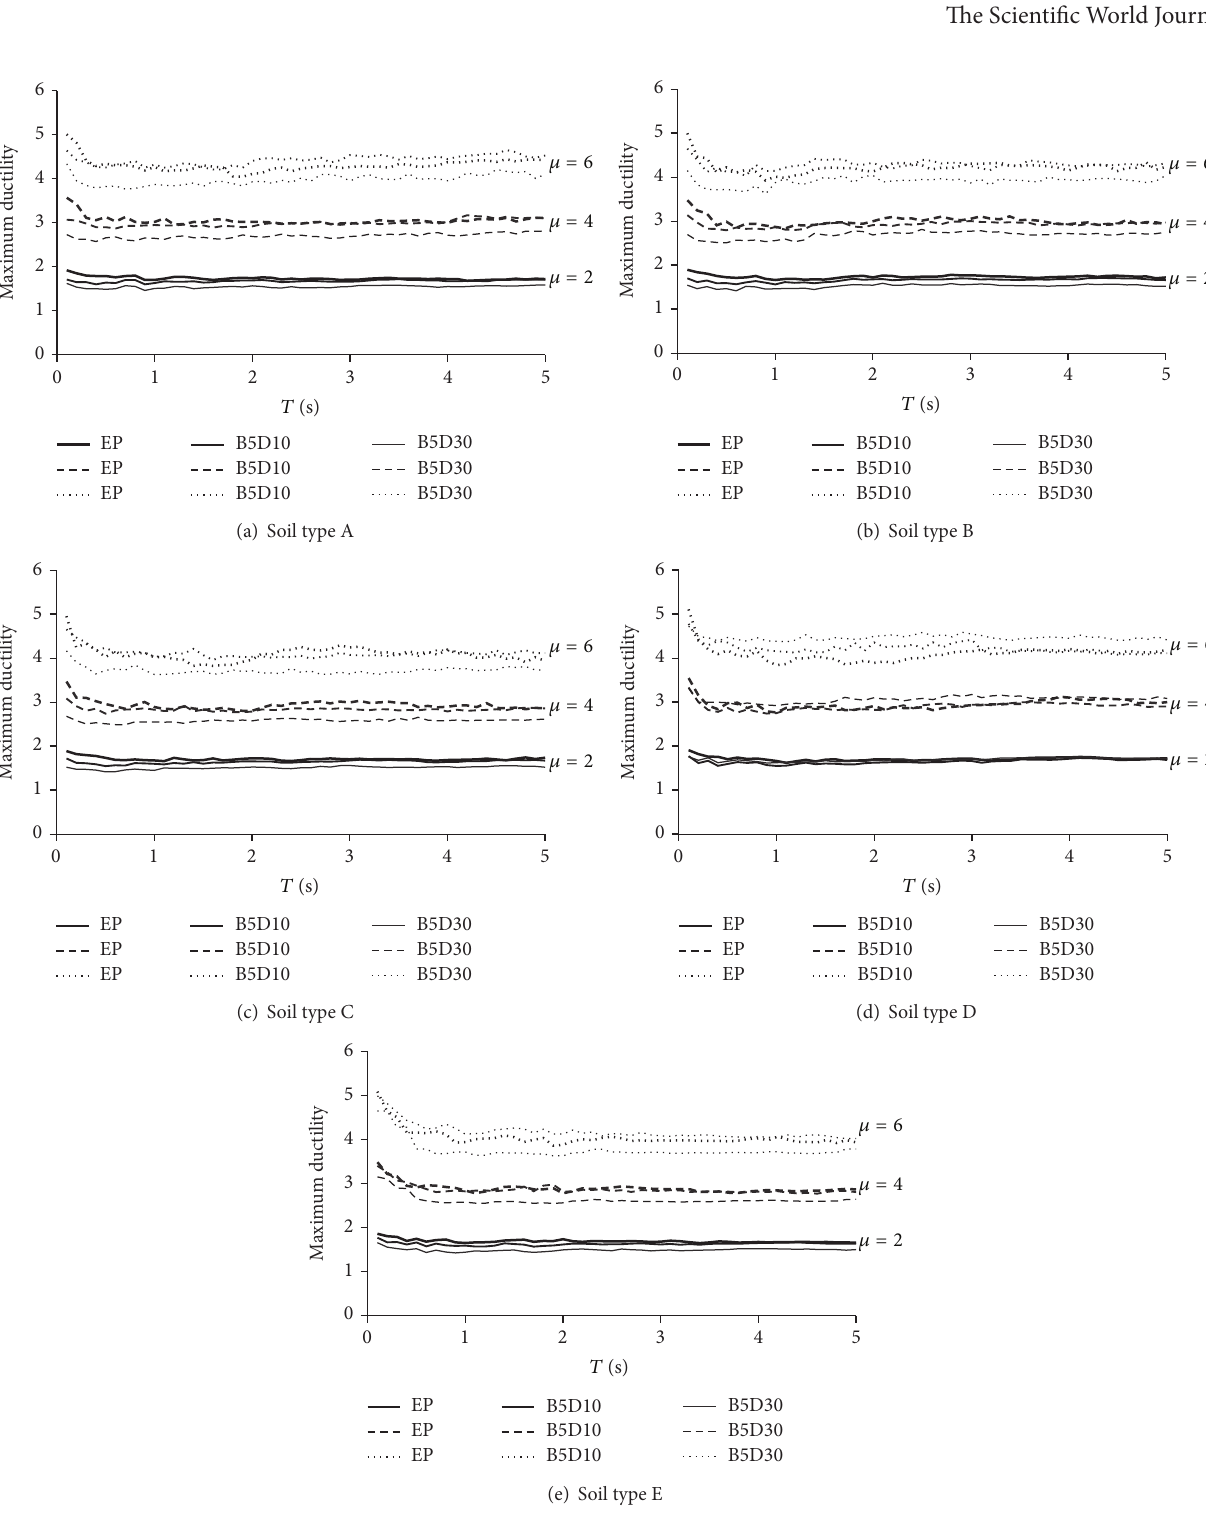
of the selected records correspond to California and have earthquake magnitudes larger than 6.0. Figure 3 illustrates the average pseudoacceleration response spectra ( 𝑆 𝑎 ) for each set of ground